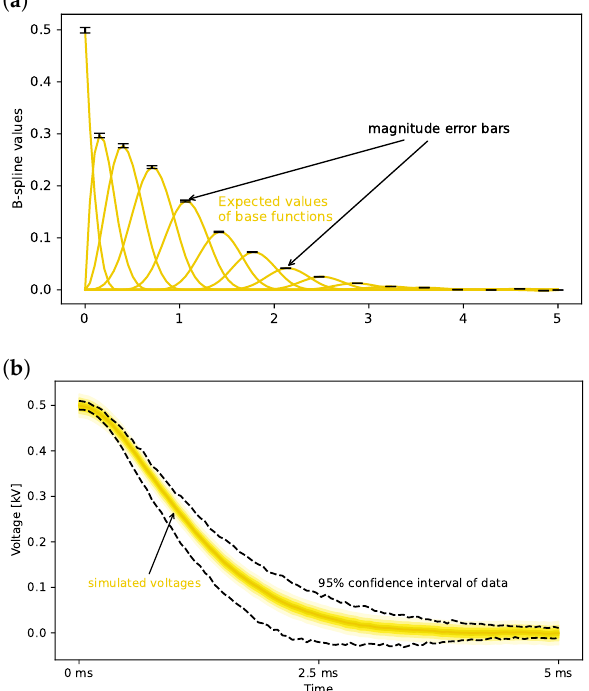
Figure 8. Bayesian model of the voltage signal gives better representation of the uncertainty than in the case of current. Plot ( a ) shows that error bars for splines further from the start are much thinner than initially. The ribbon plot ( b ) shows quantiles of simulated output values compared to point quantiles of data. As we can see there is an underestimation of uncertainty in the middle of the signal; however, initial and final quantiles are covered without overstepping the